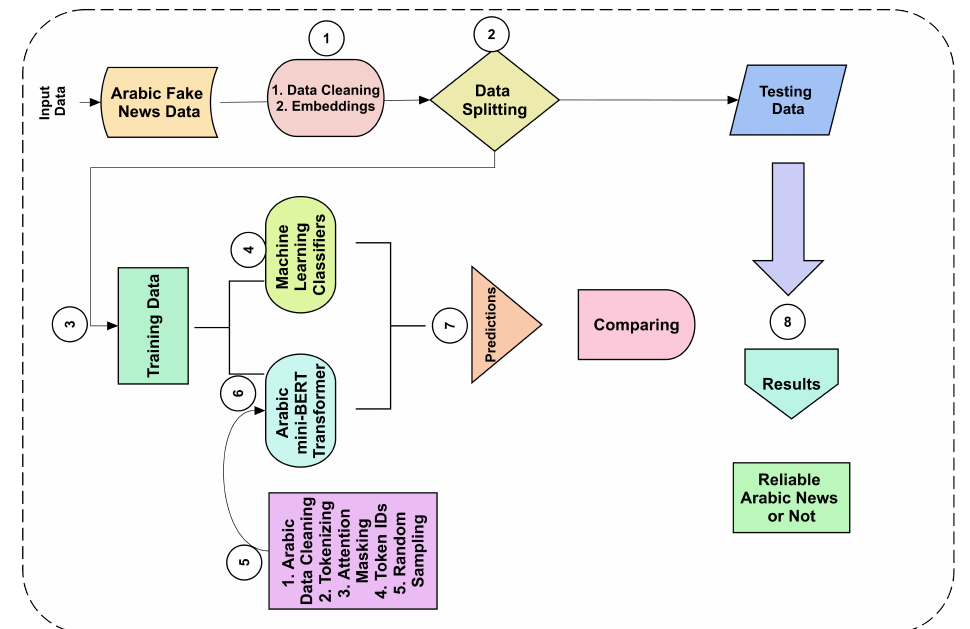
Figure 1. Primary steps of a study conducted on Arabic fake news detection using ML and mini-BERT